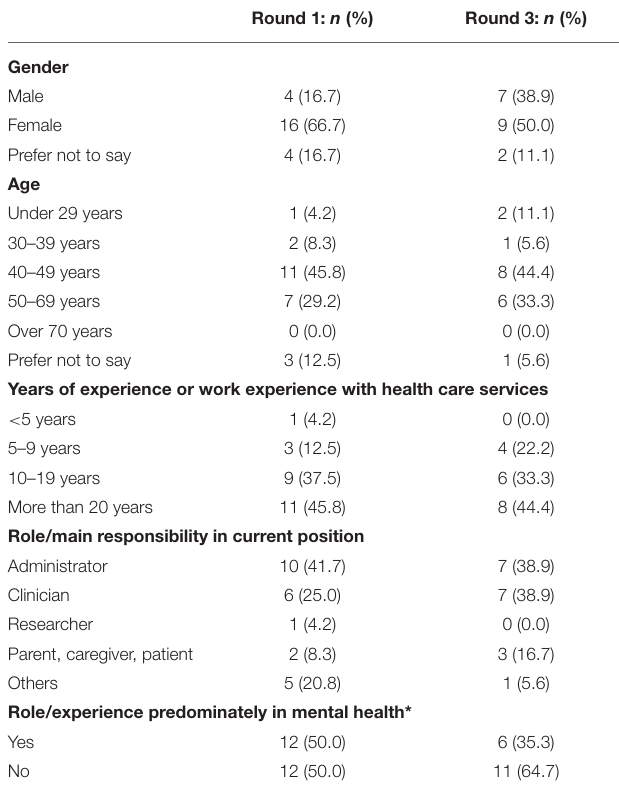
TABLE 1 | Characteristics of participants of Delphi rounds 1 and